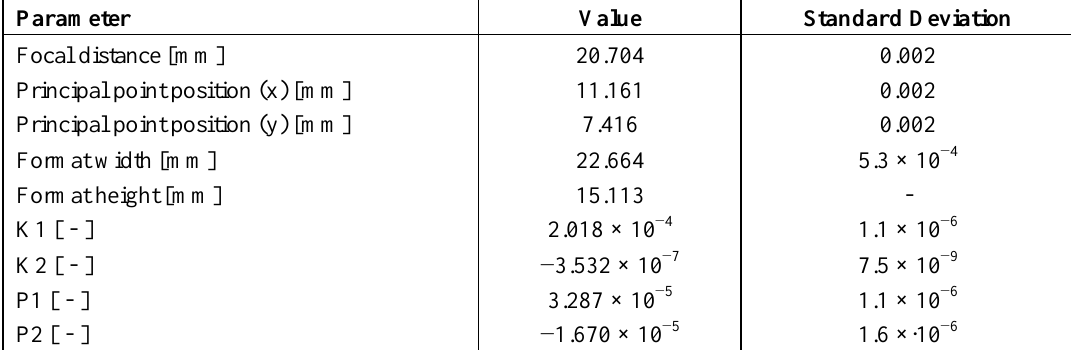
Table 1. Values of initial calibration of using conditions of Canon EOS